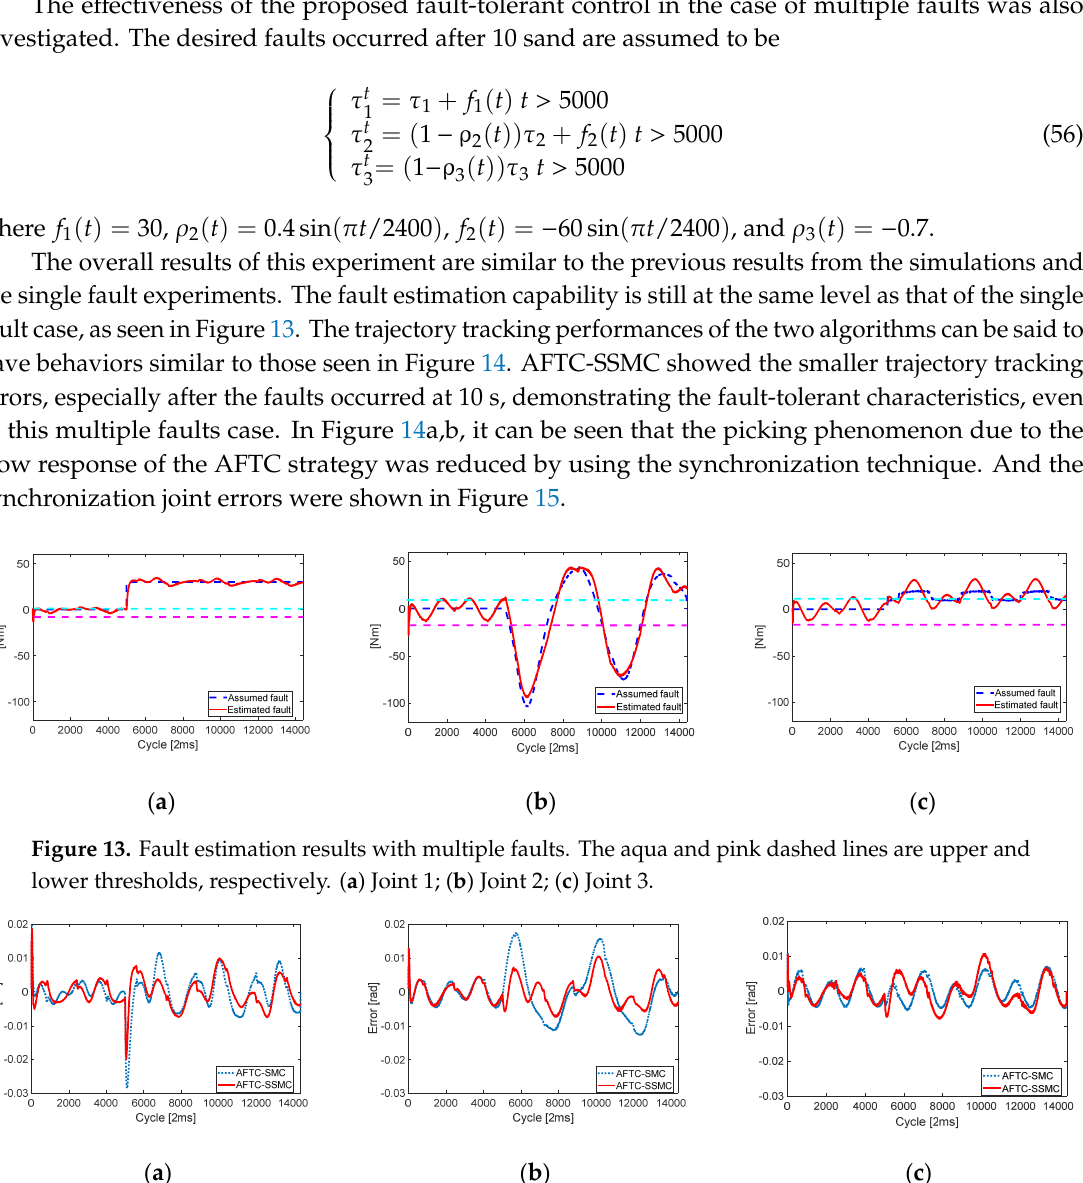
( c ) Figure 15. The synchronization error with multiple faults. ( a ) Joint 1; ( b ) Joint 2; ( c ) Joint 3. Remark 2 : In this section, the experimental results were discussed. The resulting tracking trajectory errors were shown with single and multiple faults. In a real system, the uncertainties and disturbances have a higher magnitude than that of the simulation environment. Due to the limitation of selection parameters in a real system, the robot system with PFTC-SMC failed when multiple faults occurred. Therefore, in these experimental results, only the results of AFTC-SMC and the proposed AFTC-SSMC were presented. As mentioned in Section 1, the synchronization technique does not show effectiveness in an open-chain system such as a serial robot manipulator. Therefore, before a fault occurs, both controllers have a similar accuracy level. After a fault occurs, due to the slow response of AFTCs, the controller without the consideration of the synchronization error showed a high picking value at the joint fault. The proposed controller with a constraint within the synchronization technique quickly responded to the occurrence of faults before the system had the feed-back information from fault estimation. Hence, AFTC-SSMC showed better performance than AFTC-SMC. However, in a real system, due to the limitation of adjustment controller parameters, the error at joints without faults were slightly increased when compared with those of AFTC-SMC by the synchronization technique. This characteristic may be a disadvantage of this proposed controller. However, the AFTC-SSMC still showed an acceptable performance at these actuators. 7. Conclusions In this paper, an active fault-tolerant control for a robot manipulator based on synchronous sliding mode was proposed. To verify its effectiveness, experimental implementation of the proposed control algorithm for a three degree-of-freedom FARA-AT2 robot were carried out and compared with the active fault-tolerant control with conventional sliding mode control in the both single and multiple fault cases. The results indicate that the active fault-tolerant control with synchronous sliding mode control has better fault-tolerant capability and results in better trajectory tracking performance when compared to the active fault-tolerant control with conventional sliding mode control algorithms. This fault-tolerant capability comes from synchronous sliding mode control, because each joint error is coupled and constrained due to the synchronization errors and